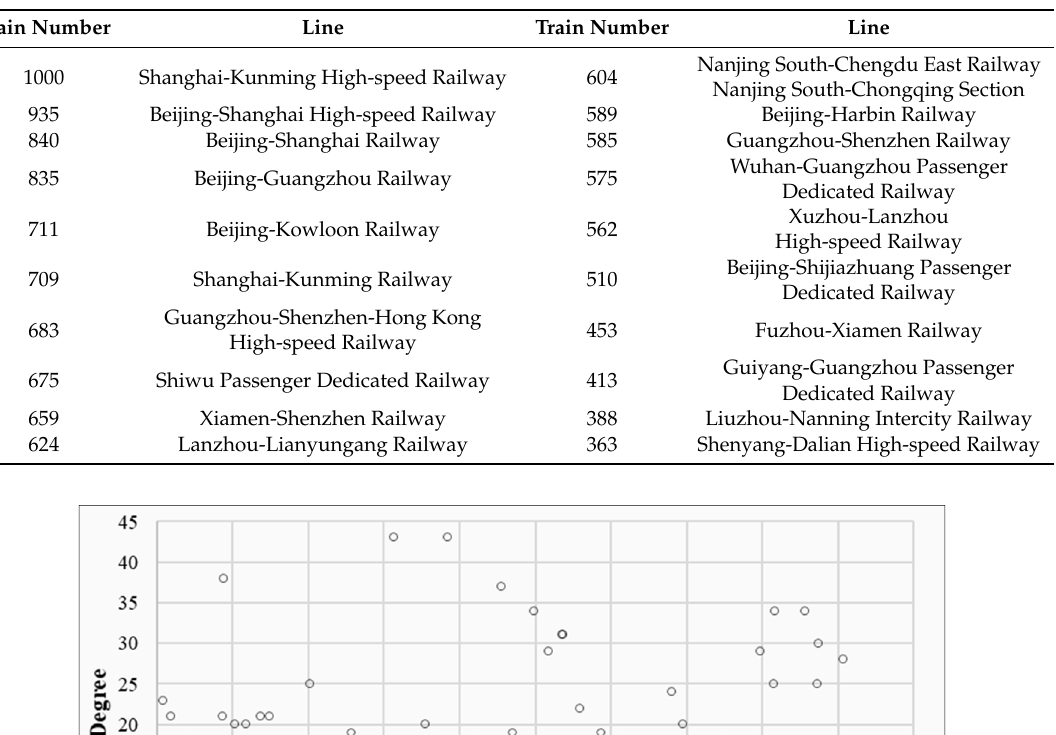
Table 2. Top 20 lines with most operating trains.